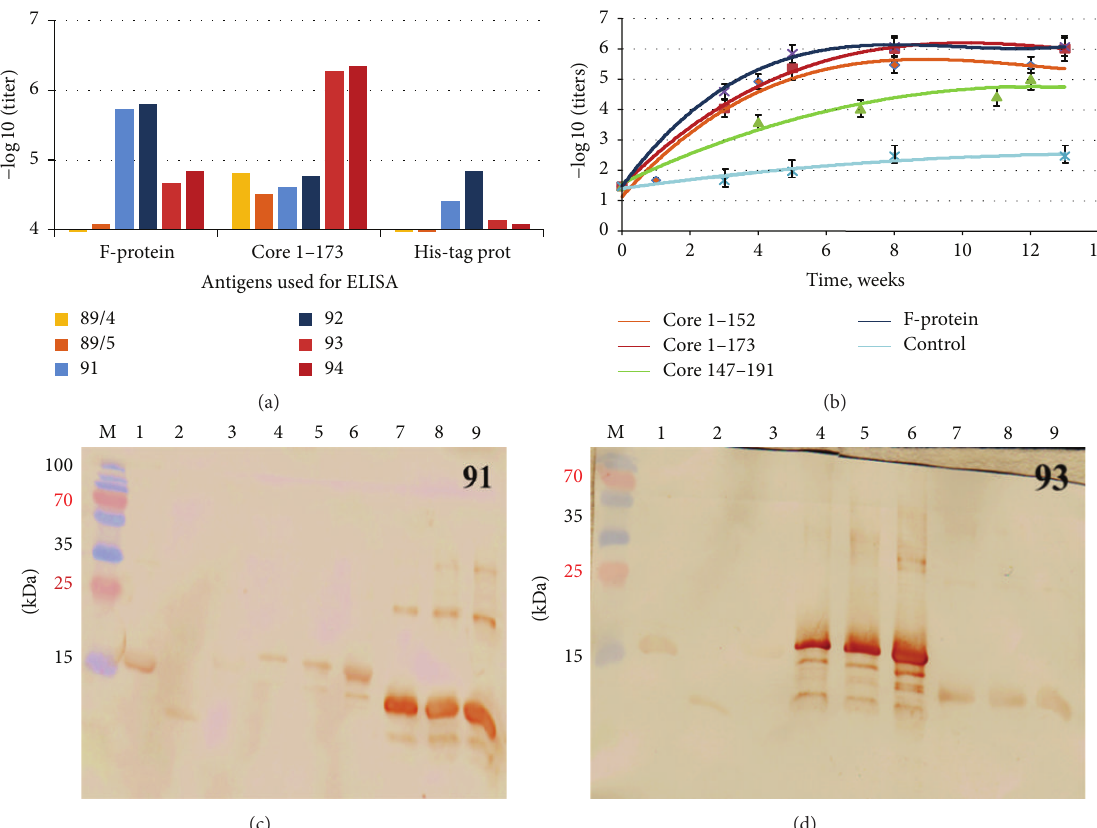
Figure 2: Antibody responses raised after immunization of rabbits with polypeptides encoded by the 5 󸀠 terminus of HCV genomic RNA. Maximumtiterofantibodiesagainsttheimmunogens(a);kineticsofthedevelopmentofspecificantibodyresponse;controlsrepresentrabbits mock-immunized with adjuvant alone; serum reactivity was tested by ELISA on plates coated with core 1–173 and F-protein (b); reactivity in Western blotting of hyperimmune sera raised against F-protein (serum of rabbit 91, (c)) and HCV core 1–173 (serum of rabbit 93, (d)). Western blotting was done with hyperimmune sera of rabbits collected by the end of immunization and diluted 1:10 4 . Lanes in panels (c and d) represent outer surface protein BB0689 of B. burgdorferi carrying 6xHis-tag (2.5 𝜇 g, lane 1), lysozyme (2.5 𝜇 g, lane 2), HBcAg (2.5 𝜇 g, lane 3), core 1–173 (0.5, 1, and 2.5 𝜇 g, lanes 4–6, resp.), and F-protein (0.5, 1, and 2.5 𝜇 g, lanes 7–9, resp.). PageRuler Plus Prestained Protein Ladder (Thermo Scientific, lane M). Position of molecular mass markers is given on the